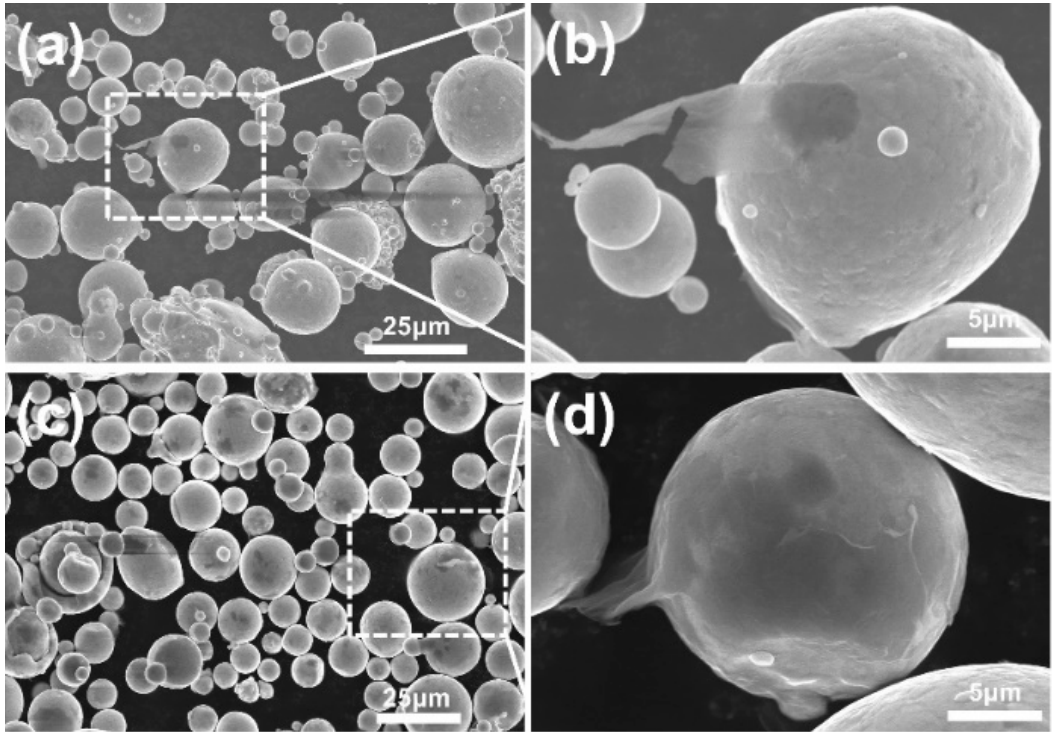
Figure 3. SEM images of the GNS reinforced FGH96 powder. ( a , b ) GNS reinforced unmodified FGH96 powders; ( c , d ) GNS reinforced PVA modified FGH96 powders.